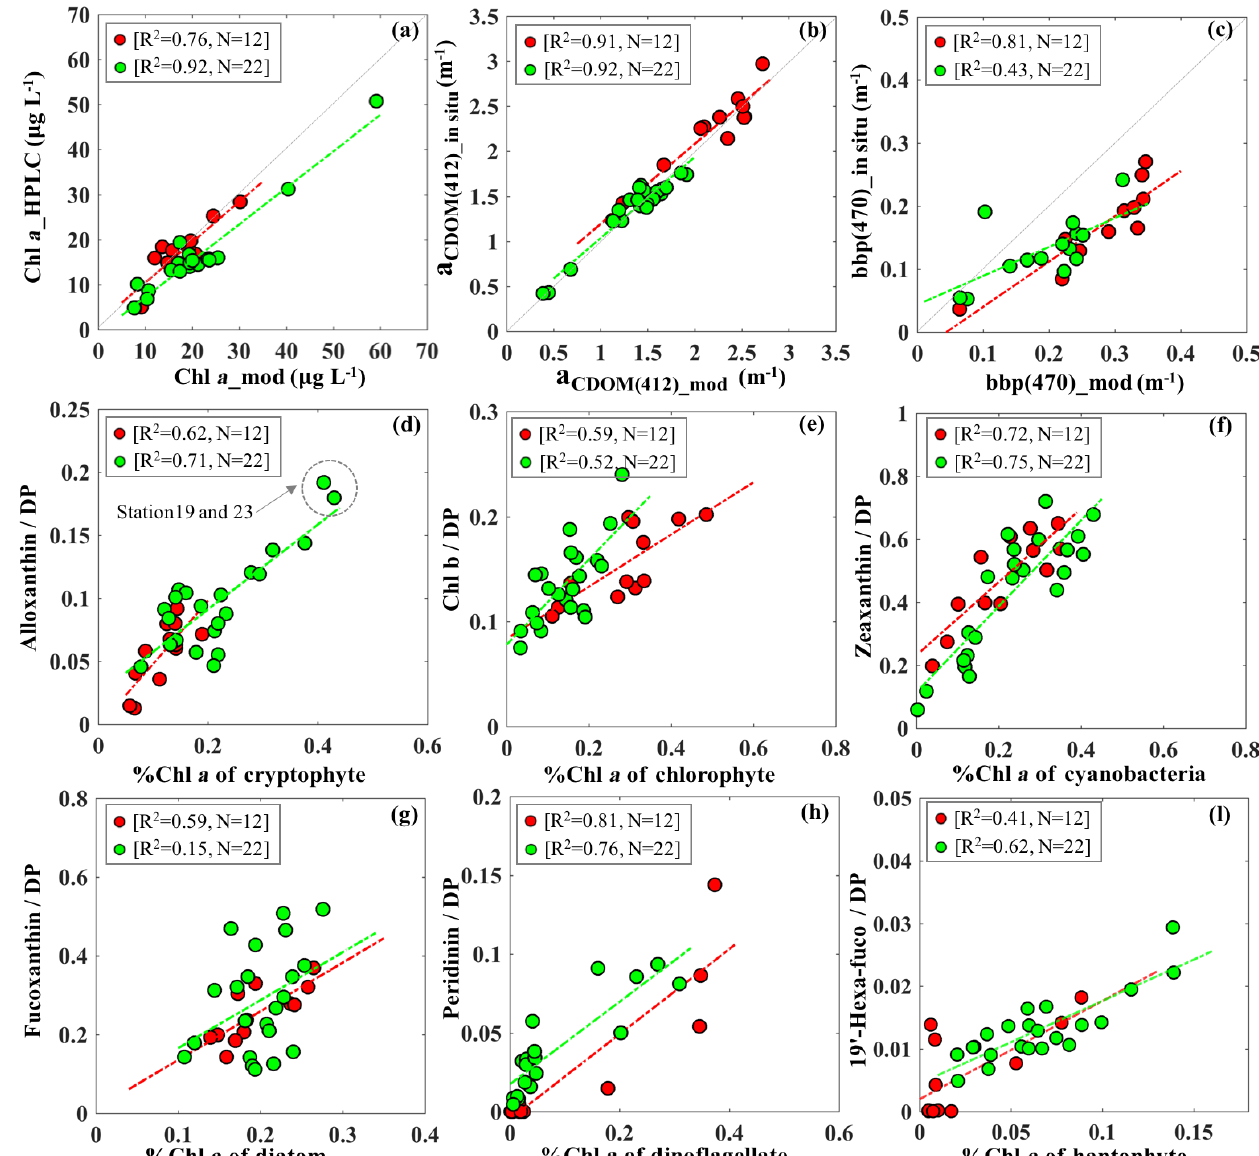
Figure 4. (a) Validation of TChl a _mod via HPLC-measured TChl a ; individual %Chl a of each detected taxa versus corresponding %DP shown with (d) cryptophyte, (e) chlorophyte, (f) cyanobacteria, (g) diatom, (h) dinoflagellate and (l) haptophyte; red and green dots indicate the samples on 29 September and 29–30 October 2017, respectively. Comparison between in situ measurements and modeled results with (b) a CDOM (412) and (c) b bp